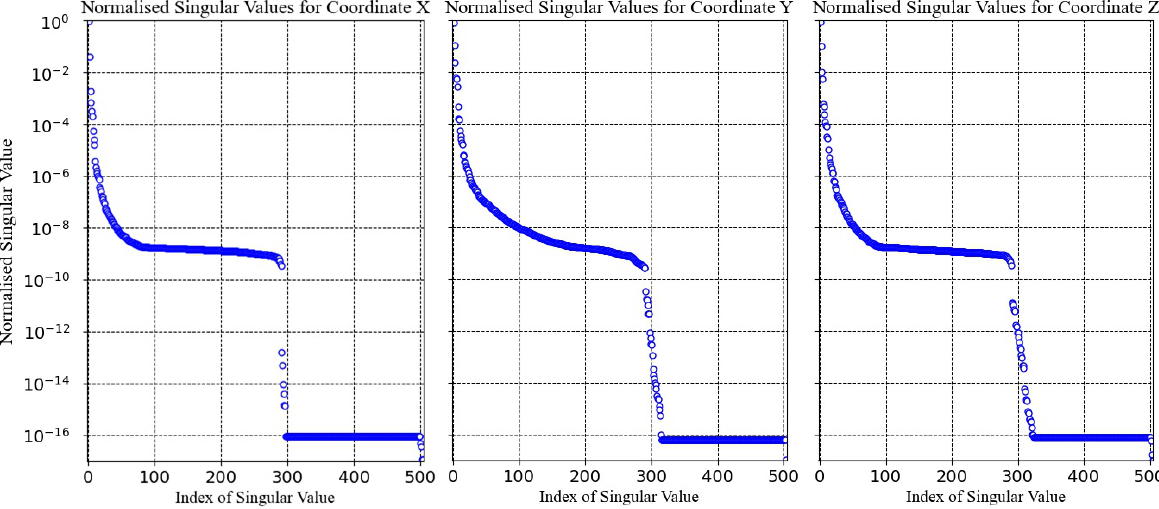
Figure 6. Normalized singular values related to the three nodal displacements.